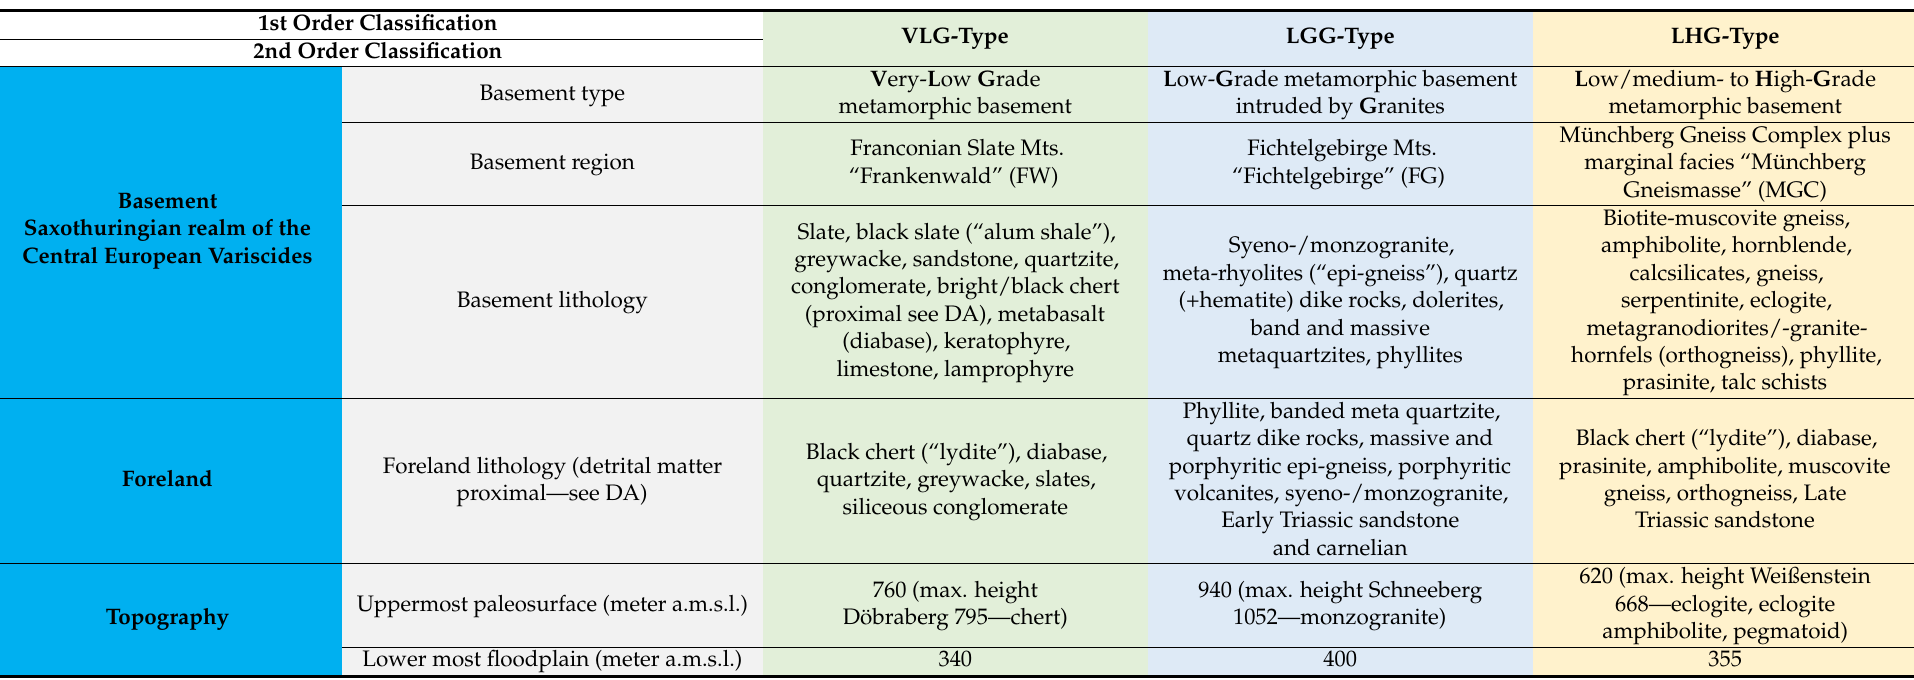
Table 1. Synoptical overview of the three straight to low-sinuosity reference drainage types as a function of the metamorphic grade and presence of intrusive rocks in the bedrock lithology. The three type were categorized according to the bedrock lithology the minerals of which decrease from left to right and the tectonic structures get obliterated in the same direction. both of which are besides climate the key elements of the origin of the SSS and form the framework stage. The rows describe the dual approach taken in the current study (see Figure 2). Blue: Geoscientific anamnesis and visual examination. Yellow: Geoscientific measurements, analysis, and computations. The “Basement region” denotes the three areas at the western edge of the Bohemian Massif (Figure 1). The “Basement and foreland lithologies” provide an overview of the lithologies shown on the geological maps 1:25,000, a compilation of which is given in Figure 1. The landform series are described according to the proposals of Easterbrook (1999) and Bridge (2003) [8,37]. Approx. 300 samples/station points have been analyzed lithologically and mineralogically. Degree of sinuosity has been calculated according to the equation referred to in the text for each river section in the maps following the recommendations of Charlton (2014) [10] and using the ArcGis software 10.2.2. The sediment petrography of gravel is based on 2442